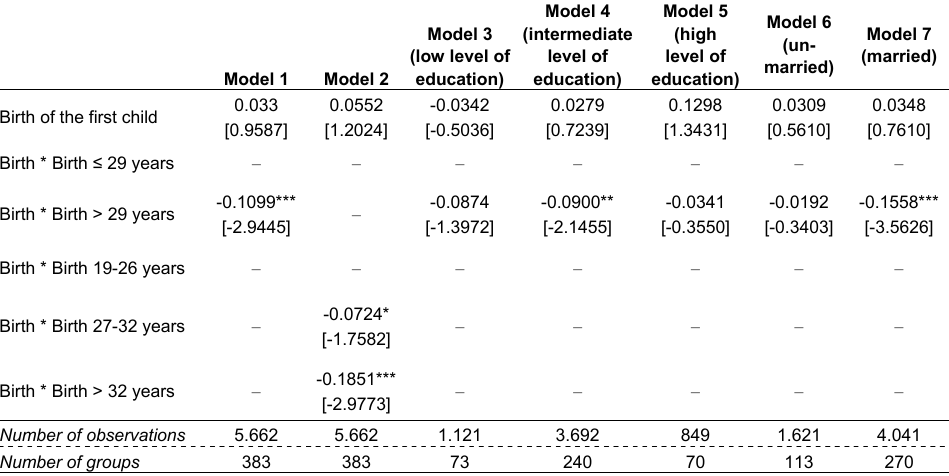
Fixed-effects results based on the ‘biological’ age at first birth (  -coefficient, t-values in